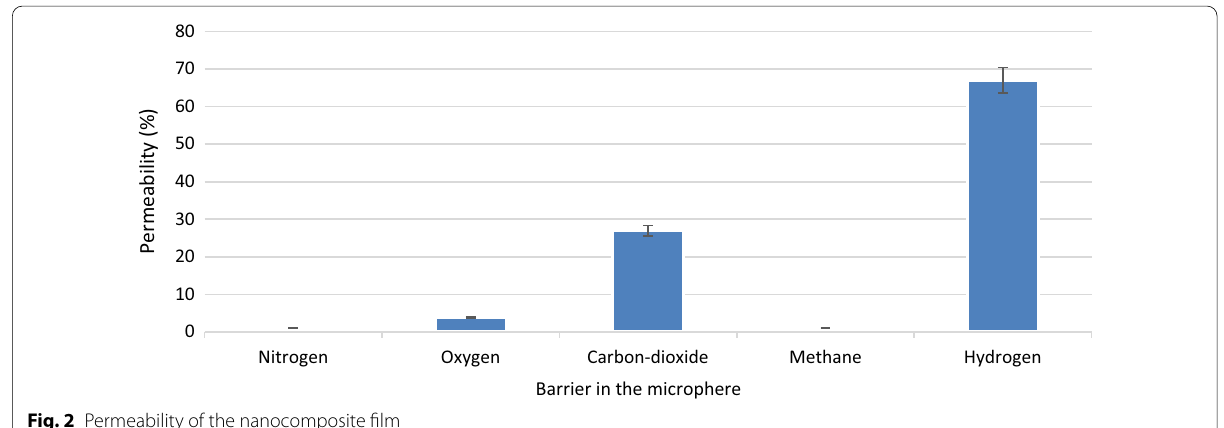
Fig. 2 Permeability of the nanocomposite